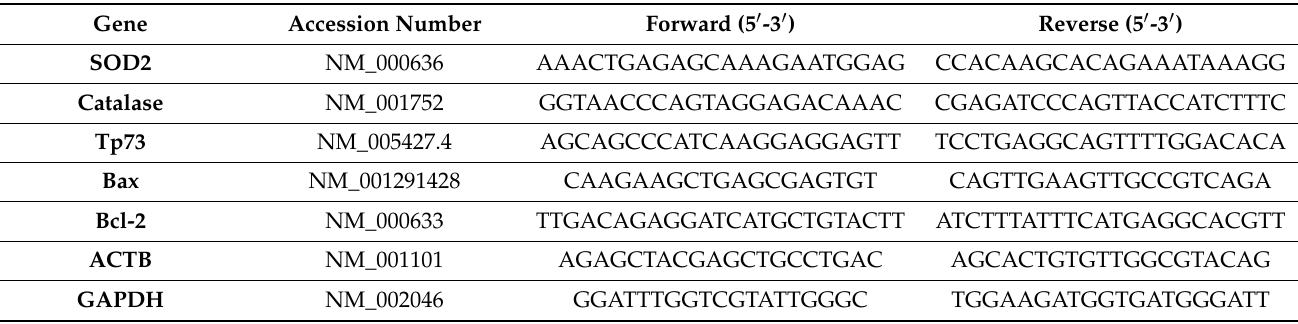
(NCBI Genbank). The selected genes of interest and house-keeping genes are listed in Table 1. Both the forward and reverse primers carry the universal tag sequences in addition to the complementary nucleotides of the targeted genes. The primers were obtained from First Base Ltd. (Seri Kembangan, Selangor, Malaysia). The forward and reverse primers were diluted in 1X TE buffer to 200 nM and 500 nM concentrations, respectively. Table 1. Details of the gene, accession number, and the reverse and forward primer sequences used in Eco Real-Time PCR analysis